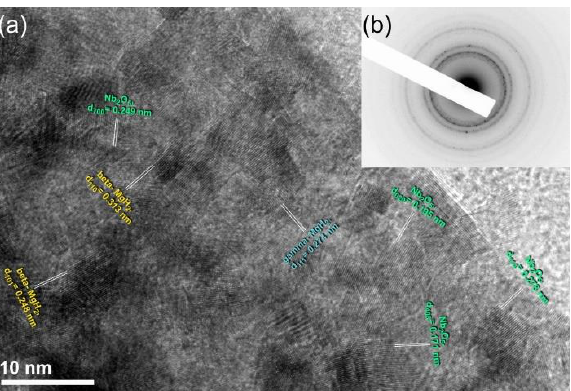
Figure 6. ( a ) FE-HRTEM image and ( b ) corresponding SADP of nanocomposite MgH 2 /10 wt.% Nb 2 O 5 powders obtained after 50 h of